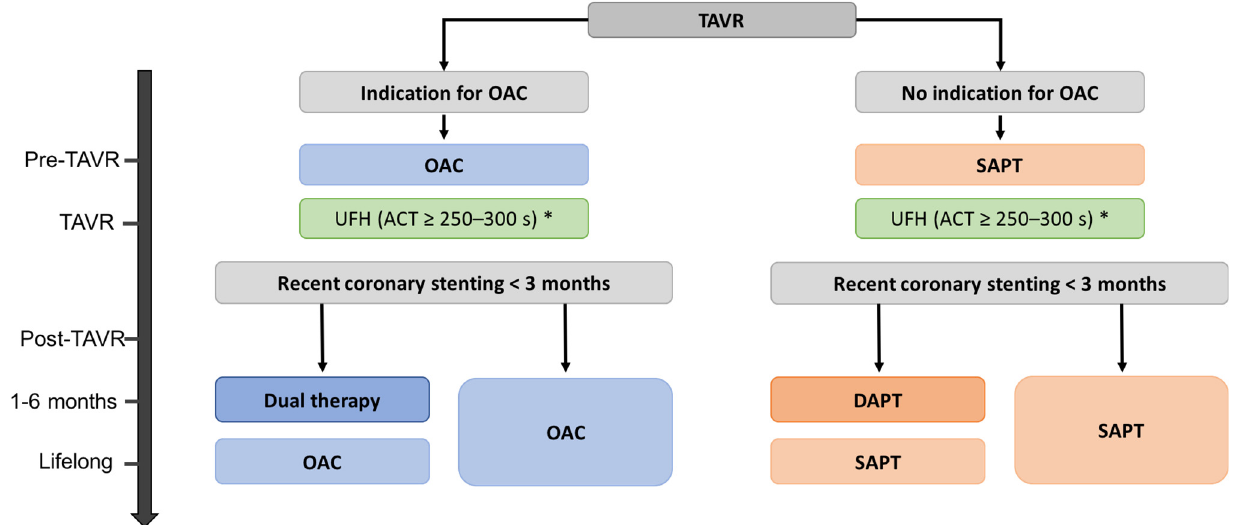
Figure 6. ESC/EACTS recommendations for antithrombotic strategy during and after transcatheter aortic valve replacement. Dual therapy: OAC plus aspirin or clopidogrel. SAPT: Low-dose aspirin or clopidogrel. DAPT: Low-dose aspirin and clopidogrel. OAC: VKA or DOAC. * Bivalirudin if heparin induced thrombocytopenia. ACT: activated clotting time; DAPT: dual antiplatelet therapy; DOAC: non-vitamin K antagonist oral anticoagulant; OAC: oral anticoagulation; SAPT: single antiplatelet therapy; TAVR: transcatheter aortic valve replacement; UFH: unfractioned heparin; VKA: vitamin K antagonist .